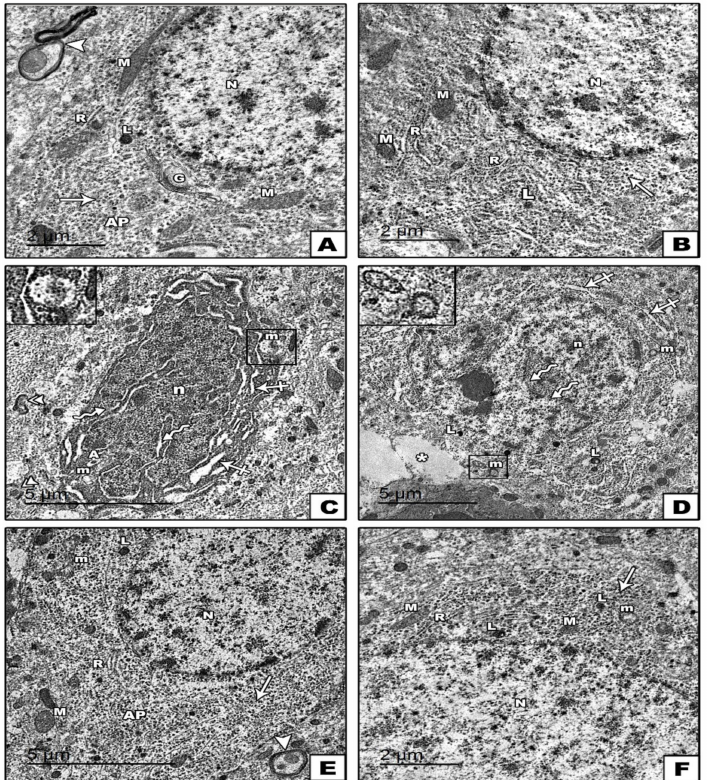
Figure 7. Electron micrographs of sections in the cerebral cortex. ( A , B ): In the control groups, ( A ) pyramidal cells with long apical dendrites (AP) and rounded euchromatic nuclei (N) are observed. The cytoplasm shows rER cisternae (R), polyribosomes (arrows), few lysosomes (L), mitochondria (M) with normal cristae pattern, and Golgi saccules (G). Notice the presence of myelinated nerve fibers with the regular smooth contour of its myelin sheath (arrowhead) in the surrounding neuropil ( B ): A granular cell with a rounded euchromatic nucleus (N) and contains rER cisternae (R), polyribosomes (arrows), few lysosomes (L), and mitochondria (M) with a normal cristae pattern in the cytoplasm. ( C , D ): In the reserpine-treated group, ( C ) pyramidal cells show irregular heterochromatic nuclei (n) with corrugated nuclear membranes surrounded by a wide perinuclear space (zigzag arrows). Mitochondria with destructed cristae (m) autophagosome (A) and markedly dilated rER cisternae (crossed arrows) are seen in the cytoplasm. The nerve fibers (double arrowheads) in the surrounding neuropil have a disrupted myelin sheath. ( D ): The granular cell shows an irregular nucleus (n) with a corrugated nuclear membrane (zigzag arrows). The cytoplasm reveals dilated rER cisternae (crossed arrows), numerous lysosomes (L), and mitochondria (m) with destructed cristae. The boxes indicate the destructed cristae of mitochondria. ( E , F ): In the fisetin-treated group, ( E ) normal pyramidal cell with apical dendrites (AP) are observed. ( F ): Normal granular cell. In both figures ( E , F ), the nucleus (N) is rounded and euchromatic, and the cytoplasm contains average rER (R), mitochondria (M) with a normal cristae pattern, polyribosomes (arrows), and few lysosomes (L). Few mitochondria (m) with destructed cristae are